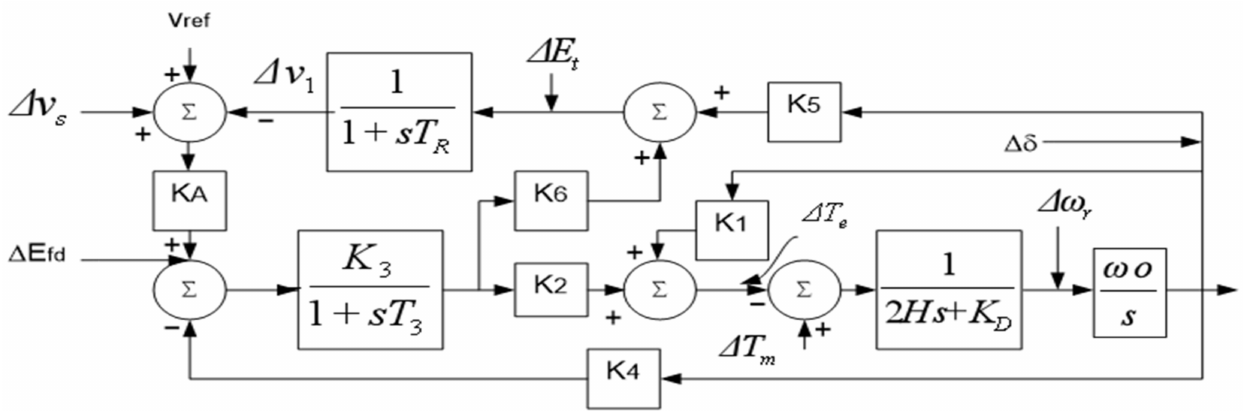
Figure 1. Block diagram of the SMIB with an